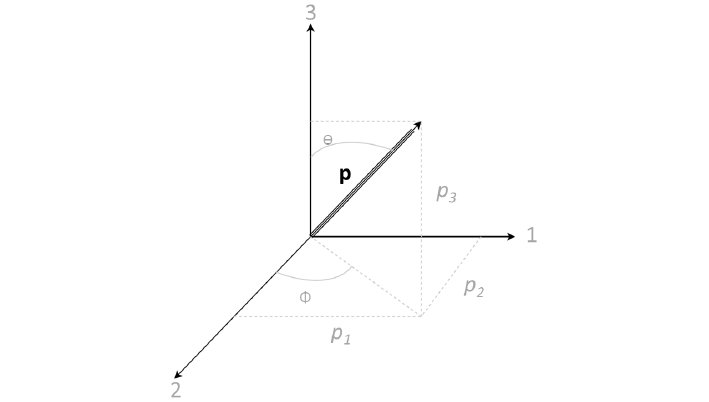
Figure 2. Unit vector representing the orientation of a single rigid